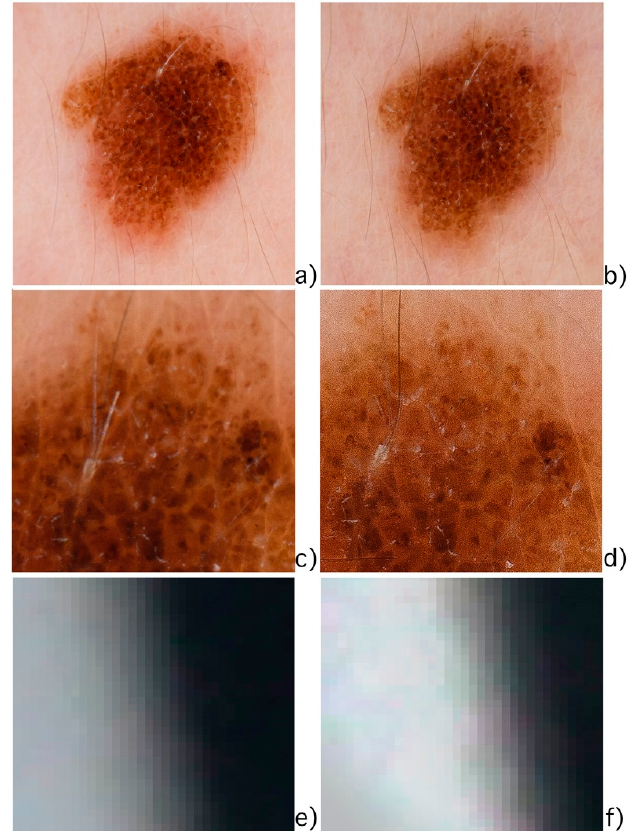
Figure 7. Influence of sharpening in a mole dermoscopy image captured with a Canon EOS M10 camera with a DermLite 4 DL dermoscope ( a ) with a low sharpening level ( b ) with a high sharpening level, ( c ) a low sharpening level in partial image evaluation, ( d ) a high sharpening level in partial image evaluation, ( e ) cropped image of slanted edge in low sharpening level, and ( f ) cropped image of slanted edge in high sharpening level.